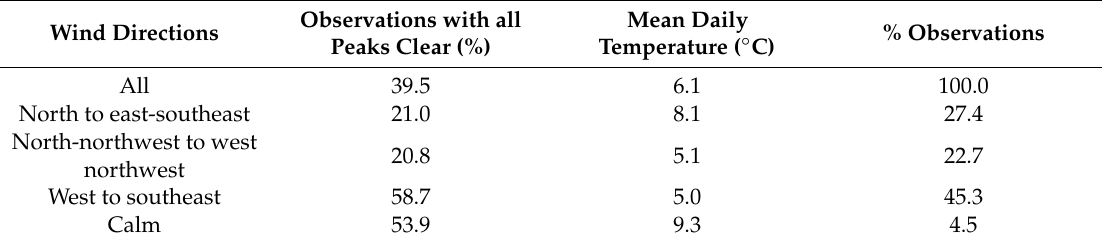
Table 3. Observations for which all peaks were clear of cloud, Perseverance Harbour Basin, 1 March to 3 October 1991. Data from Reference